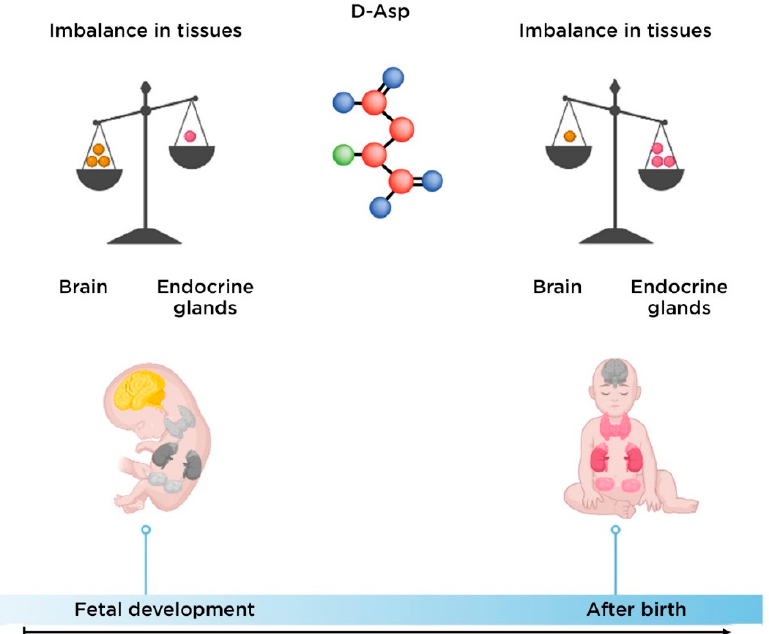
Figure 5. Change in D-aspartate balance between brain and endocrine tissue in the human ontogen- esis.